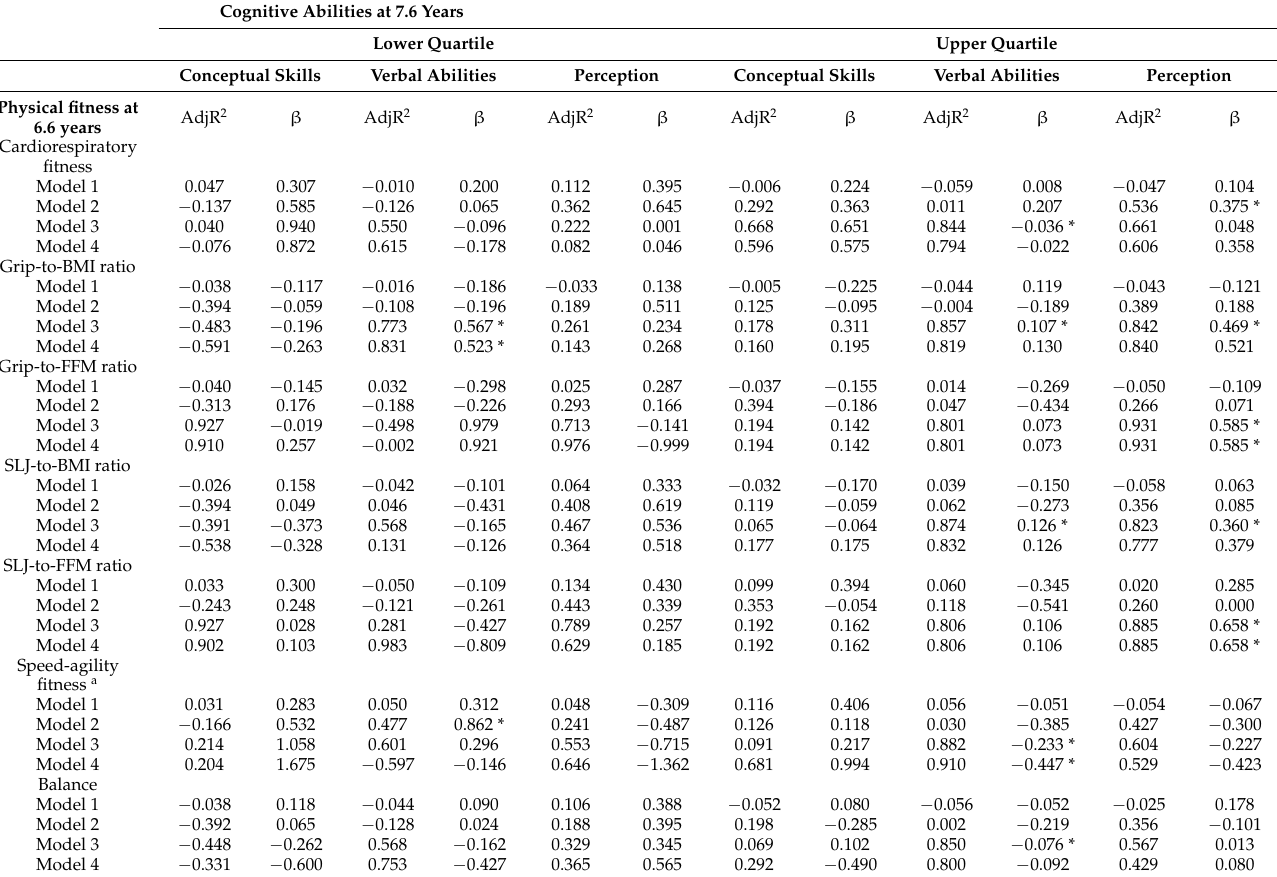
Table 3. Associations of physical fitness at 6.6 years (final year of kindergarten) with cognitive abilities at 7.6 years (1st grade at school) in kindergarten MVPA-based children of lower (25%) and upper (75%) quartiles. Cognitive Abilities at 7.6